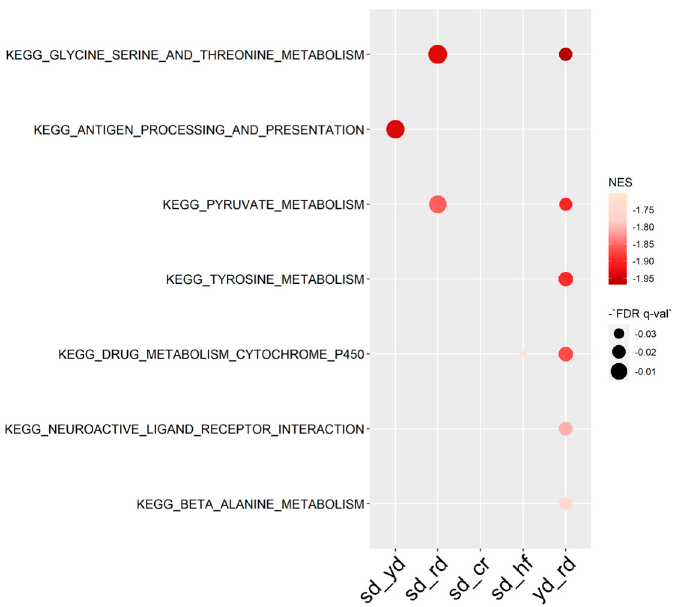
Figure 5. GSEA report on KEGG terms of H3K4me3 signal around the TSS.